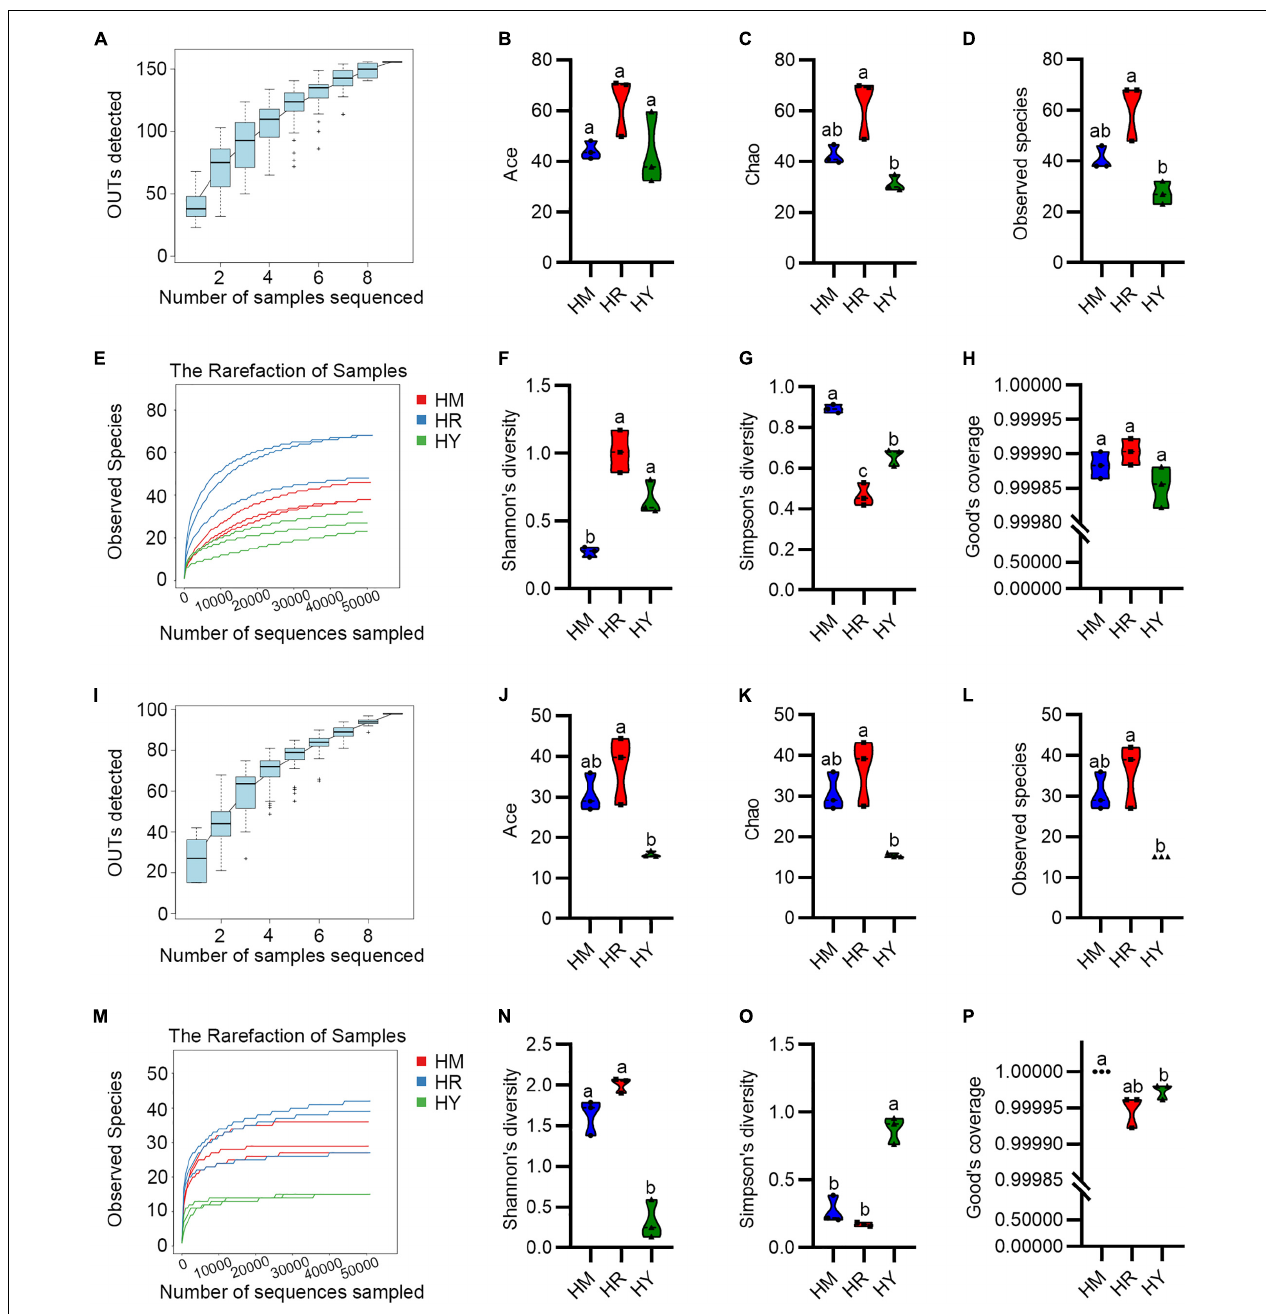
FIGURE 2 | The Alpha diversity of intestinal microbiota in adult H. axyridis fed with different diets. (A–H) The Alpha diversity of bacteria. (I–P) The Alpha diversity of fungi. The different small letter above bars indicate significant difference by Tukey’s test ( P <